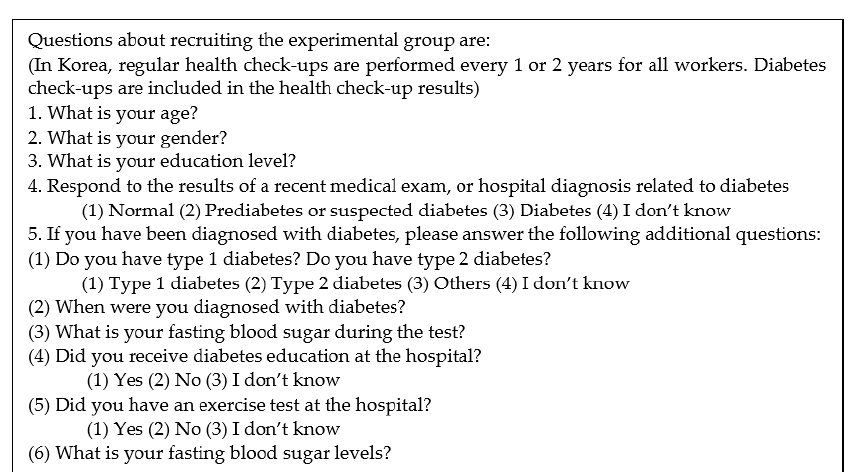
Figure 13. Questions about recruiting the experimental group.